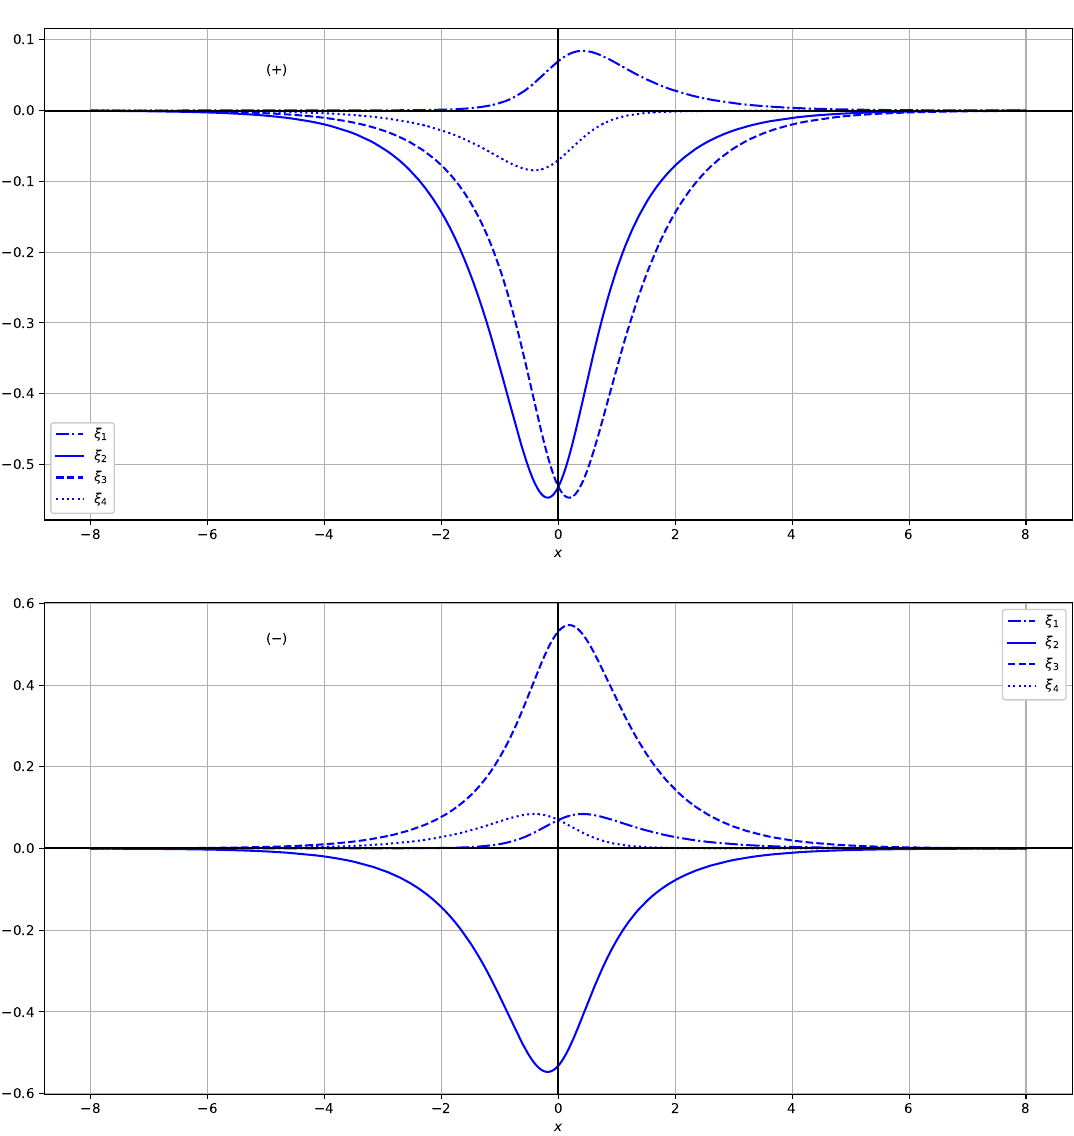
Figure 18 . Numerically simulated bound state components as functions of x for positive parity σ = +1 (Top figure) and negative parity σ = − 1 (Bottom figure). They are hosted by the kink with θ 0 = 1 . 0 (blue kink in the figure